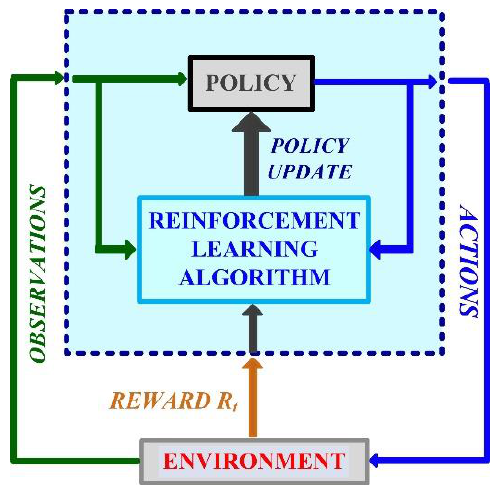
Figure 12. The bloc diagram of the components of the RL-TD3 agent.